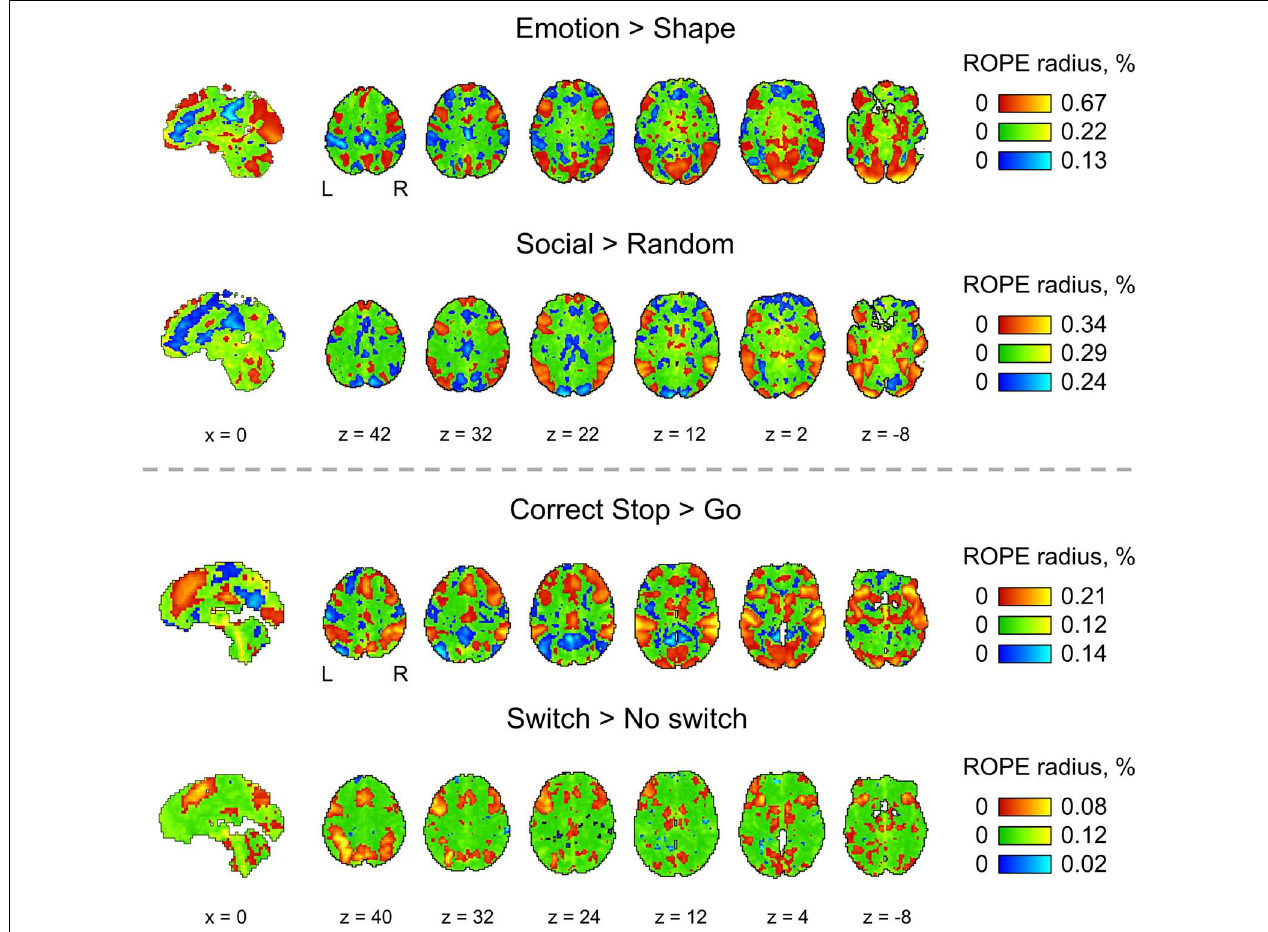
FIGURE 10 | The ROPE maps. Four contrasts were chosen for the illustration purposes (two event-related and two block-design tasks). The ROPE maps are presented using different colors for the ‘activated,’ ‘deactivated,’ and ‘not activated’ voxels. The green bars represent the minimum ROPE radii at which voxels with a PSC close to zero can be classified as ‘not activated’ based on the ‘ROPE-only’ decision rule. The red and blue bars represent the maximum ROPE radii at which voxels of which the PSC deviates from zero can be classified as ‘activated’ and ‘deactivated,’